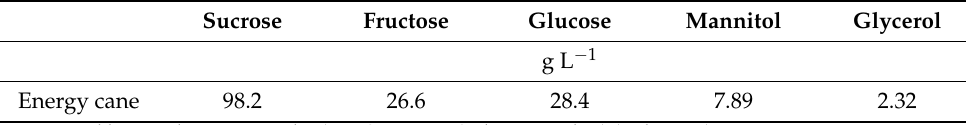
Table 1. Composition of the energy cane juice used in Study